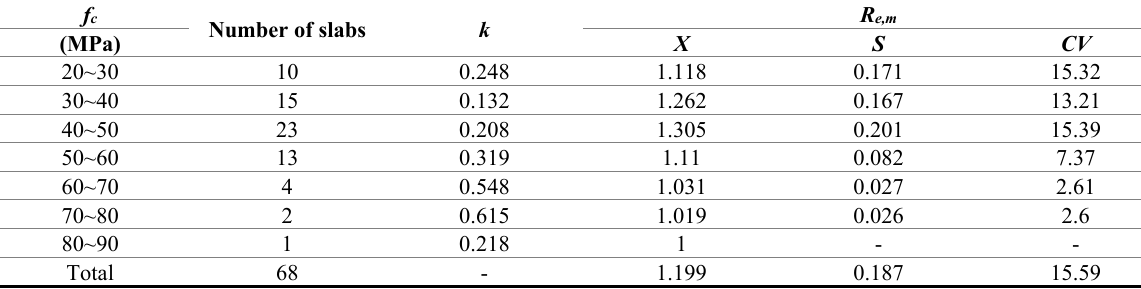
Table 3. Experimental / theoretical rupture load ratio by strength class.